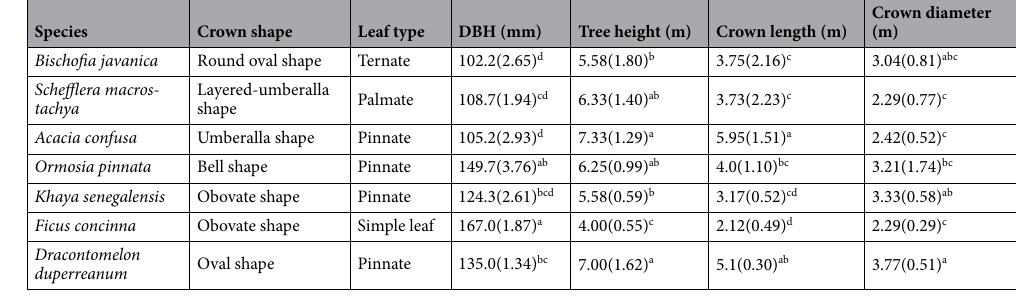
Table 1. Basic information of sample trees. Values in parentheses are stand deviations. Means followed by the same letter are not different at p = 0.05 (Kruskal–Wallis test). Values sharing the same superscript letters are not significantly